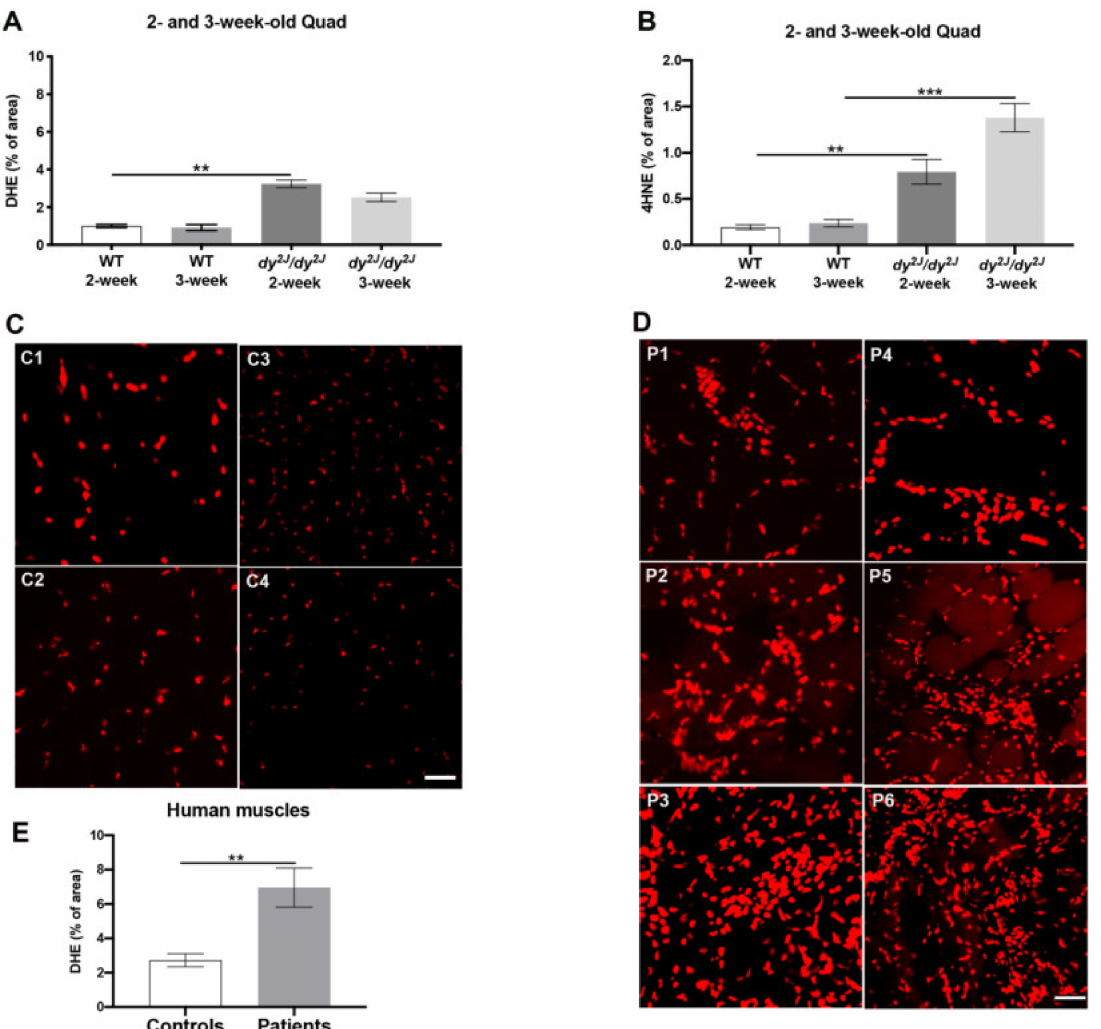
Figure 1. ( A , B ): Dihydroethidium (DHE)- and 4-hydroxynonenal (4HNE)-positive areas in quadriceps muscles of 2- and 3-week-old animals; ( C ) Representative DHE staining of four control individuals (C 1 –C 4 ); ( D ) Representative DHE staining of the six patients (P 1 –P 6 ); ( E ) DHE-positive areas in four control individuals and six patients. Results are expressed as mean ± SEM in 5 WT and 6 dy 2J / dy 2J (DHE staining, 2-week-old mice), 4 WT and 6 dy 2J / dy 2J (DHE staining, 3-week-old mice), 4 WT and 4 dy 2J / dy 2J (4HNE staining, 2-week-old animals), 5 WT and 5 dy 2J / dy 2J (4HNE staining 3-week-old animals). ** p < 0.01, *** p < 0.001. Bar: 50 µ